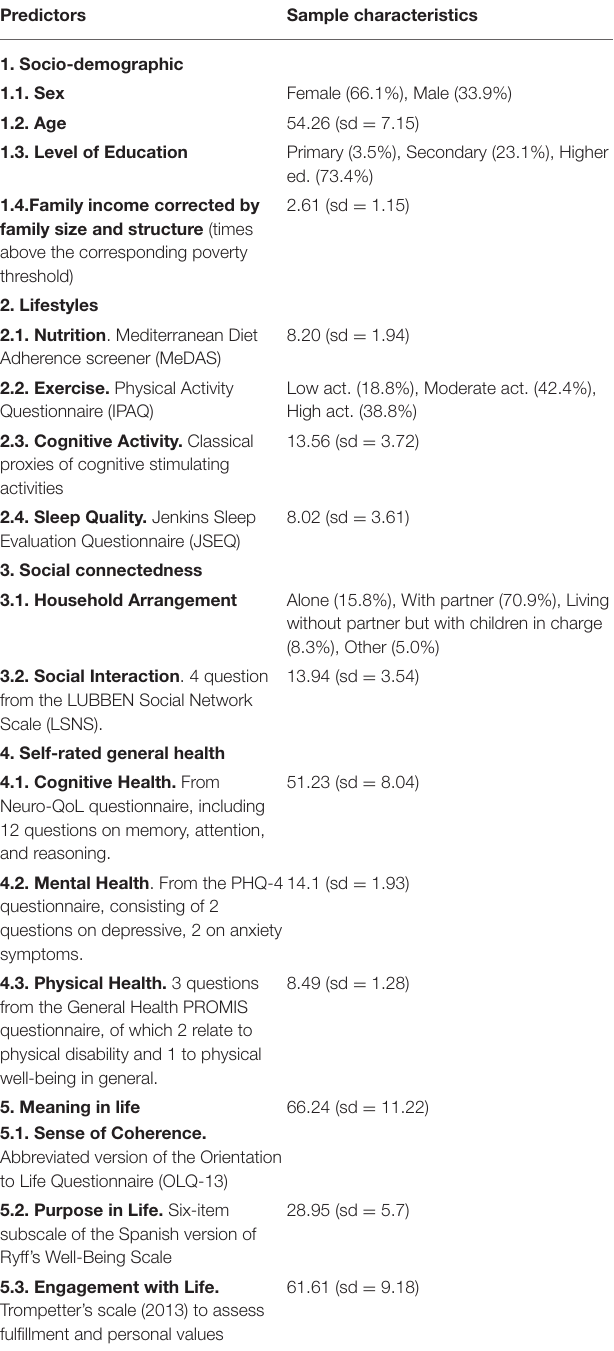
TABLE 1 | Potential risk factors for loneliness included in the study with sample characteristics. Predictors Sample